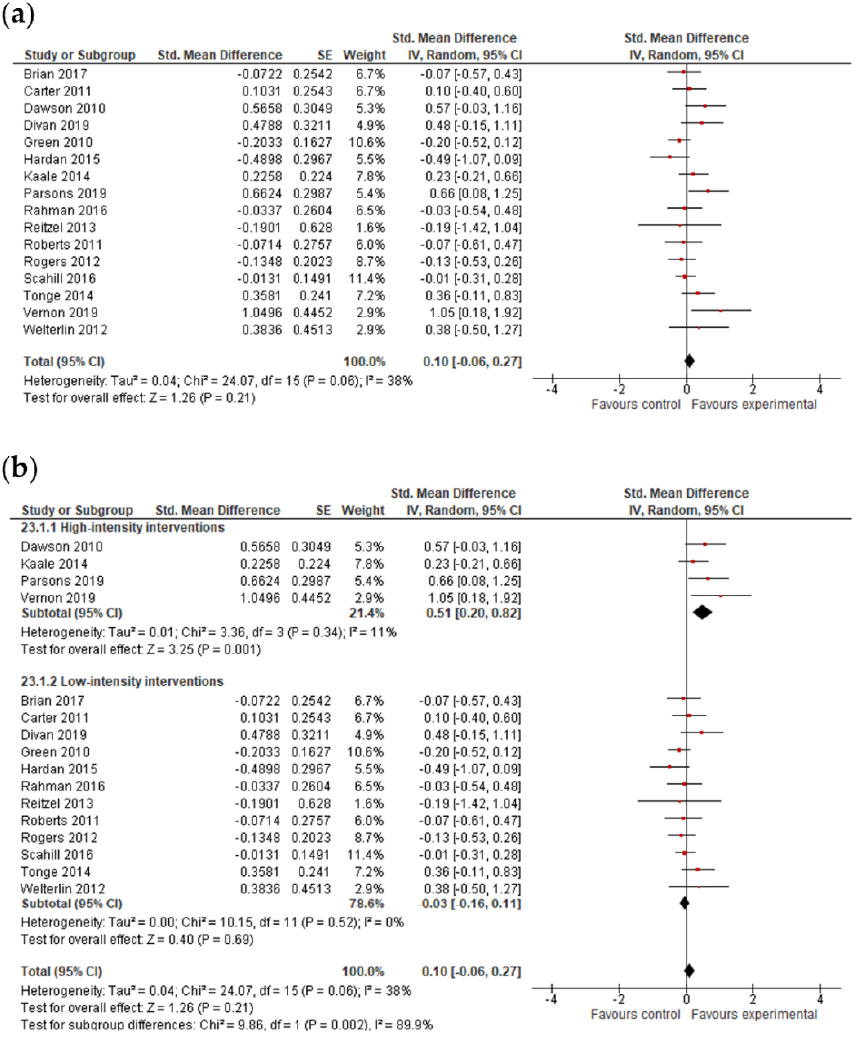
Figure 8. Forest plots for socialization results. ( a ) Overall effect [28–31,35,38,39,43–45,47,48,50,55,58,59]. ( b ) Subgroup analysis: intensity of intervention.